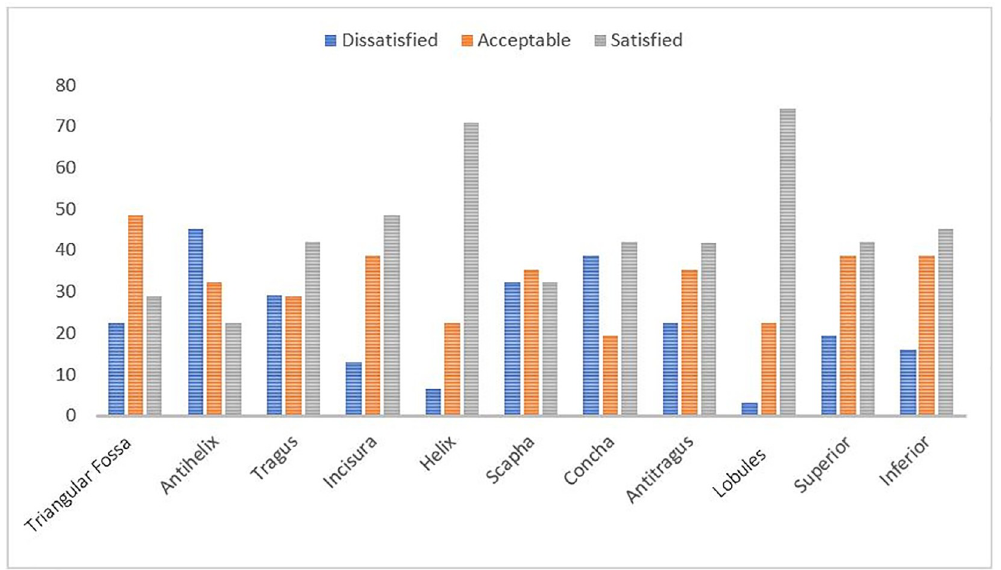
Fig 3. Satisfaction level of the patients with microtia based on the aesthetic quality of the ear subunit.